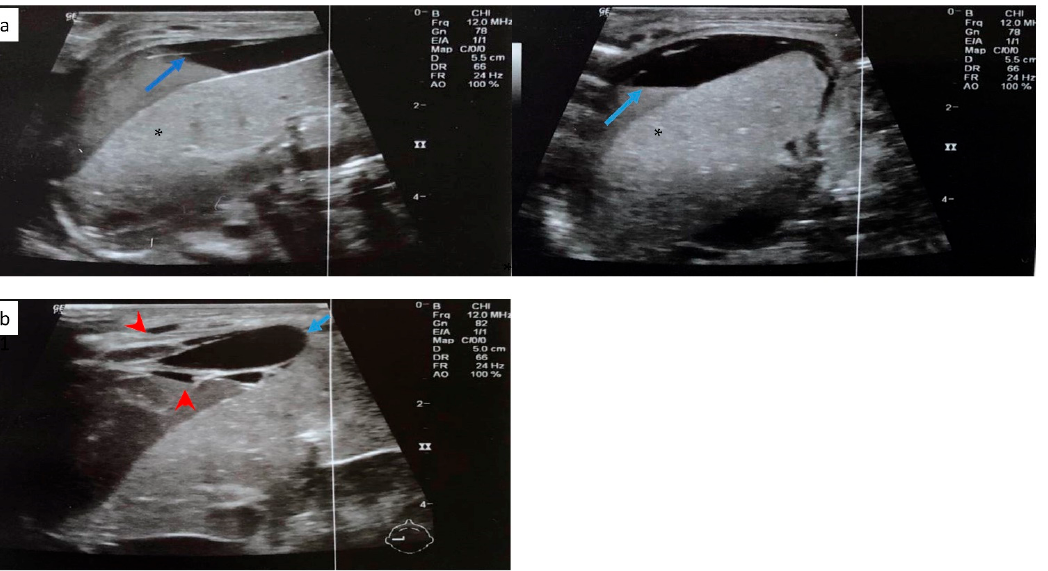
Figure 5. ( a ) Free perihepatic fluid collection (blue arrow) in abdominal ultrasound. ( b ) Abdominal ultrasound depicting subcapsular hematoma of the liver (blue arrow) and hemorrhagic collections in the peritoneal cavity (red arrowhead). Normal liver parenchyma is noted with asterisk (*).